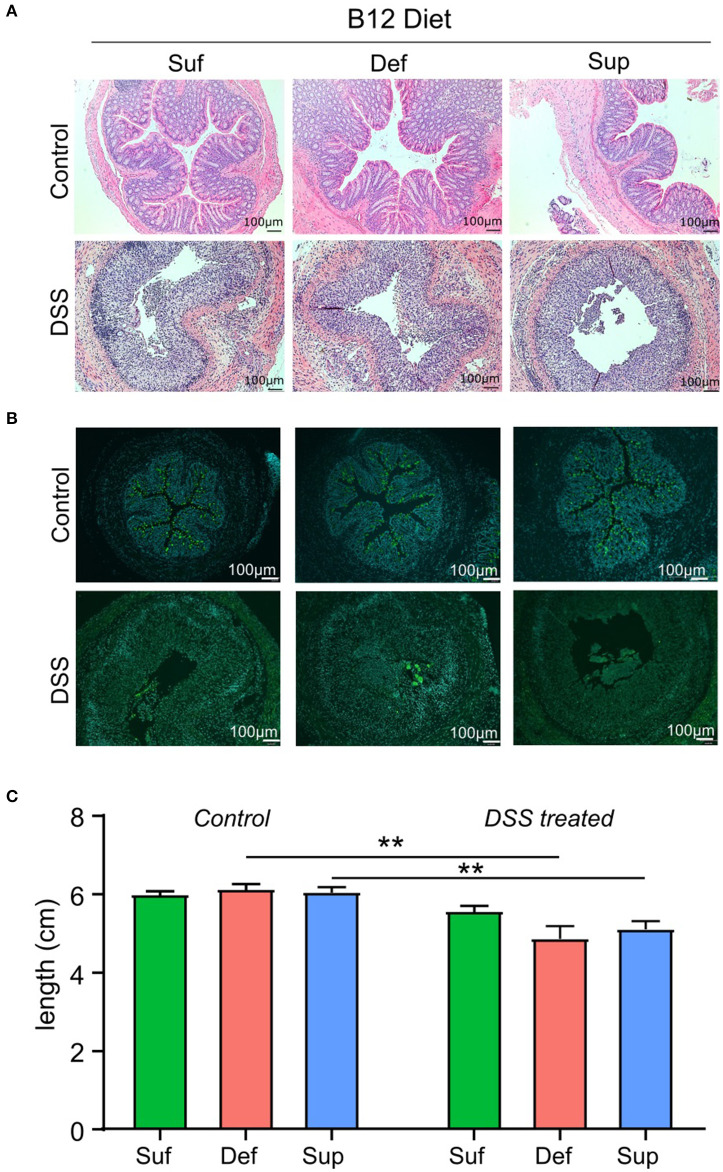
Markers of colonic epithelial injury. (A) Representative hematoxylin and eosin staining of colonic sections showing normal morphology in control groups and marked tissue damage. (B) Representative images depicting the presence of Muc2 punctate staining in colonic tissue from control mice and loss of Muc2 staining in animals administered DSS and fed either vitamin B12 sufficient or vitamin B12 supplemented diets. (C) Colon length measurements post-mortem were similar between all diet groups for both control and DSS-induced colitis mice. Significant differences between colon lengths in vitamin B12 deficient and vitamin B12 supplemented mice exposed to DSS were observed (two-way ANOVA, *P < 0.05, **P < 0.01, n = 5), values are expressed as means + SEM.